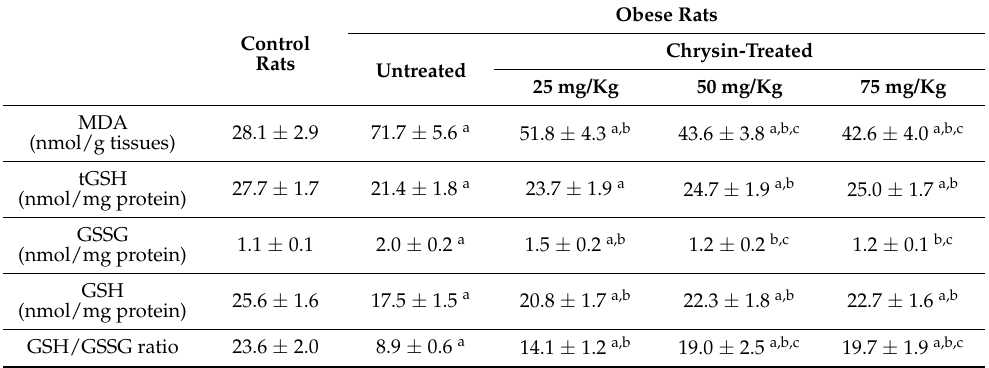
Table 4. Hepatic MDA, total GSH, GSSG, reduced GSH, and GSH/GSSG ratio in control rats and obese rats untreated or treated with different doses of chrysin.